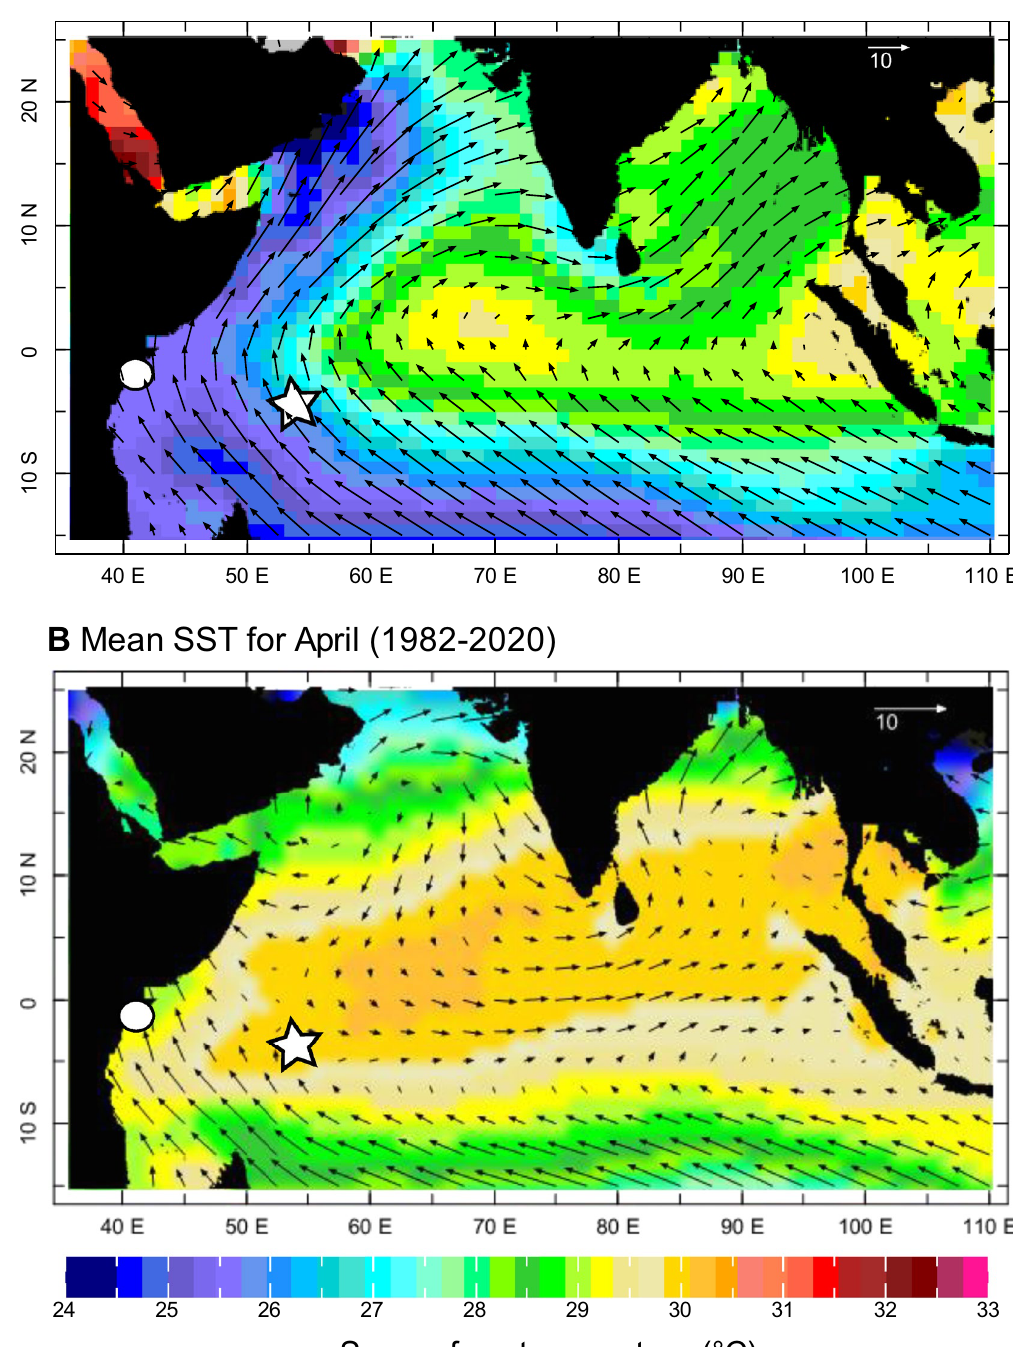
Figure 1. Monsoon circulation in the Indian Ocean. Mean SST in °C (colors) and surface winds (vectors) during ( a ) August and ( b ) April, averaged over 1982–2020. SST data is taken from AVHRR SST 25 , wind data from the NCEP/NCAR 40 reanalysis 67 . White dot: Kenya, star: Seychelles. Charts computed at IRI/LDEO Climate Data Library (http:// iridl. ldeo. colum bia. edu). Date accessed: 31 March